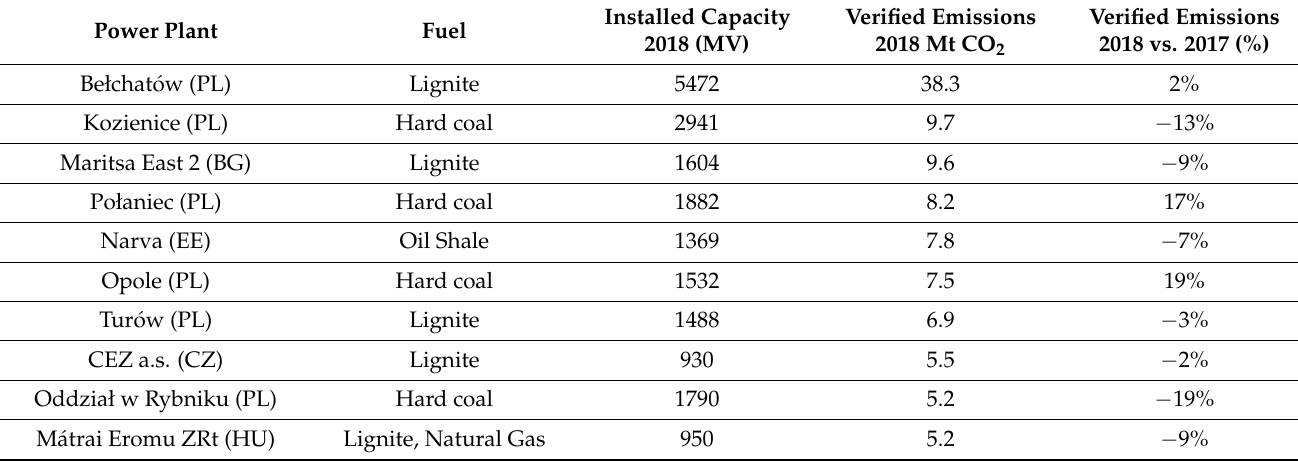
Table 2. Power plants from CEE countries that were among the 30 highest emitting power plants in the EU in 2018. Installed Power Plant Fuel